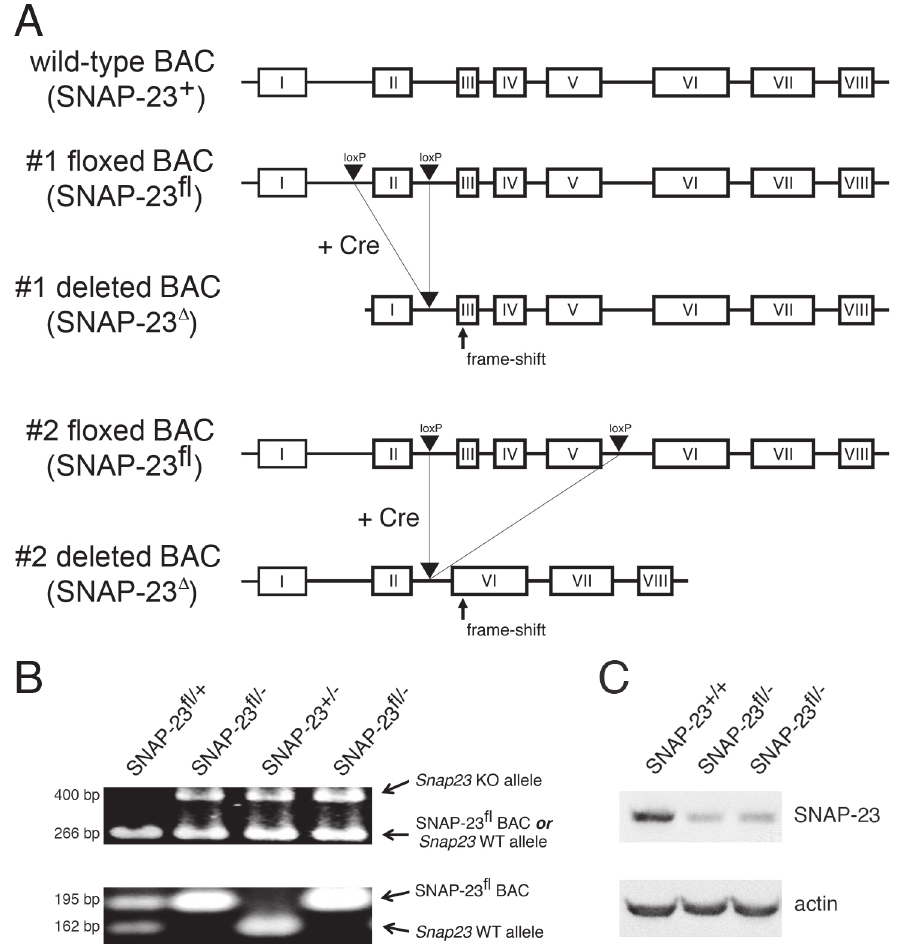
Fig 1. Generation of mice containing a floxed SNAP-23 allele. (A) A 179 kb BAC clone containing the entire SNAP-23 gene was mutated by introducing loxP sites surrounding exon II alone (#1 floxed allele) or surrounding exons III-V (#2 floxed allele). Expression of Cre will result in the excision of exon II alone in the #1 floxed allele construct or exons III-V in #2 floxed allele construct. Each deleted allele introduces a frame shift that prevents the synthesis of in-frame SNAP-23 exon-encoded amino acids. (B) Typical PCR genotyping analysis of mice used in this study. The upper panel shows results obtained using a PCR reaction that can distinguish the deleted SNAP-23 allele present in SNAP-23 +/- mice (492 bp) from either the wild-type SNAP- 23 allele or the floxed SNAP-23 BAC transgene (266 bp). The lower panel shows results obtained using a PCR reaction that can distinguish the floxed SNAP-23 BAC transgene (195 bp) from the wild-type SNAP-23 allele present in SNAP-23 +/- mice (161 bp). (C) Spleen cells were isolated from wild-type mice (SNAP-23 +/+ ) and two representative floxed SNAP-23 BAC transgene mice on a SNAP-23-/- background (SNAP-23 fl/- ) and the cells were lysed and analyzed by SDS-PAGE and immunobloting with SNAP-23 and actin antibodies. Quantitative densitometry revealed that the floxed SNAP-23 BAC expression of SNAP-23 was approximately 50% that found in wild-type